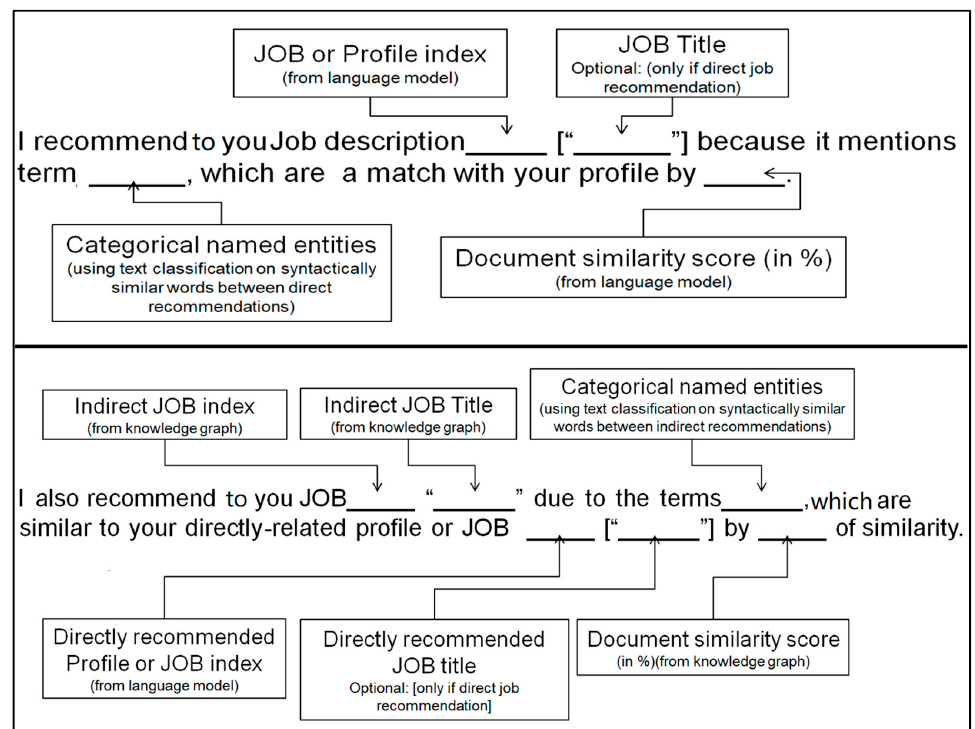
Figure 11. Two templates are used to generate the textual explanations. The first template is designed for direct recommendations, where only the link between the user profile and the job posting is explained. The second template includes information about the intermediate link between the user profile and the job posting, within the transitive relation.